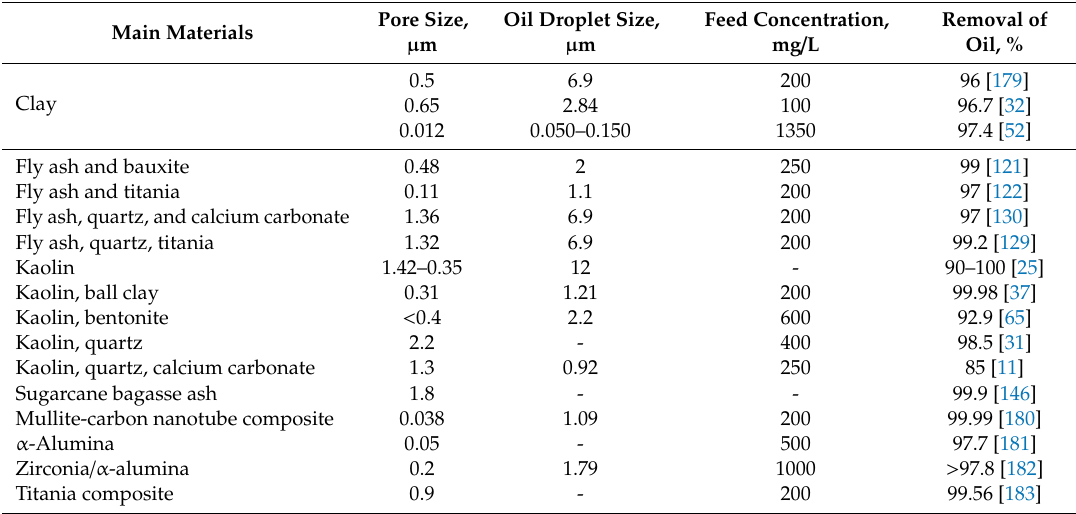
Table 4. Comparison of oil separation ability of ceramic membranes prepared from low-cost and conventional